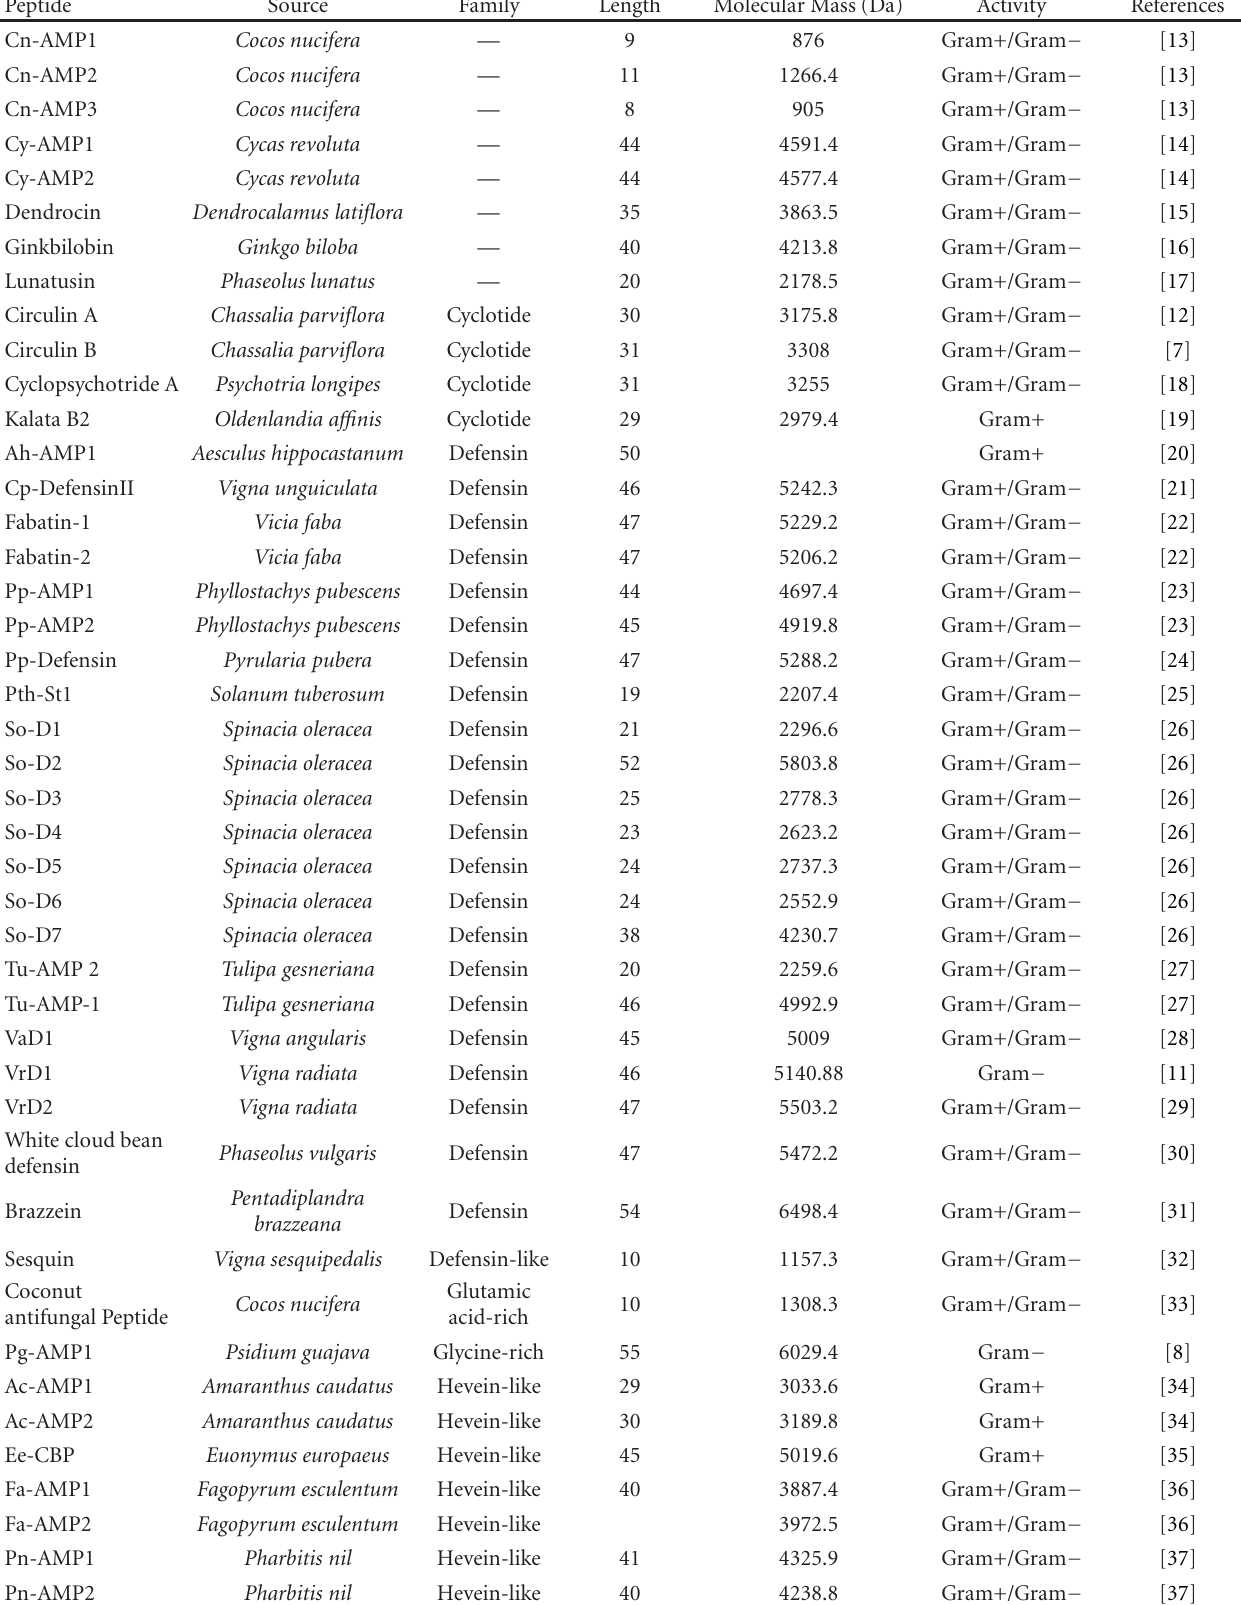
Table 1: Plant antibacterial peptides: physical and antibacterial